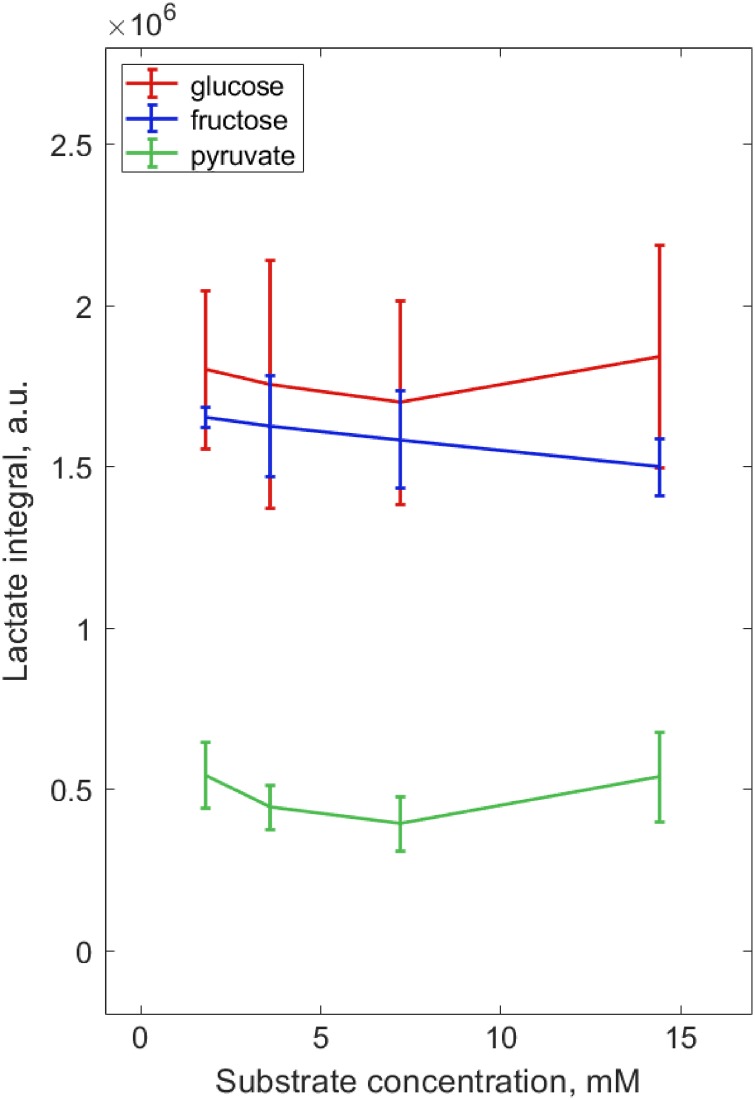
Normalising the lactate integral for sperm concentration and plotting against substrate concentration showed that sperm metabolism was not limited by substrate availability as tested by Kruskal–Wallis. Sperm were tested over a 4 h incubation (n = 3) with 13Cu-glucose, 13Cu-fructose or 13C1-pyruvate (shown in blue, red and green respectively) at 1.8 mM, 3.6 mM, 7.2 mM and 14.4 mM concentrations.